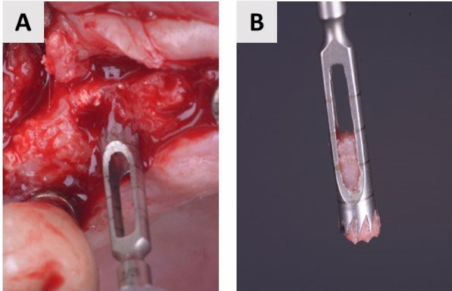
Figure 6. Biopsy collection. ( A ) Trephine bur in maxilla. ( B ) Closer view of the bone